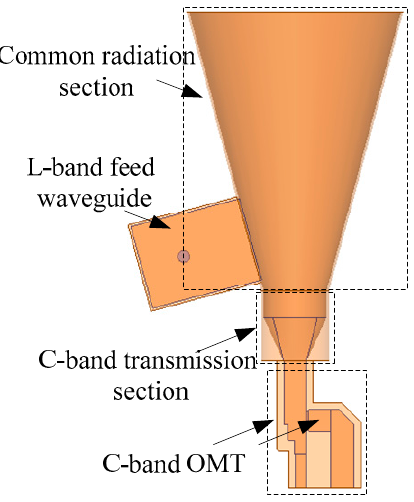
Figure 3. Schematic illustration of the L / C-band common aperture antenna. OMT: ortho-mode transducer.